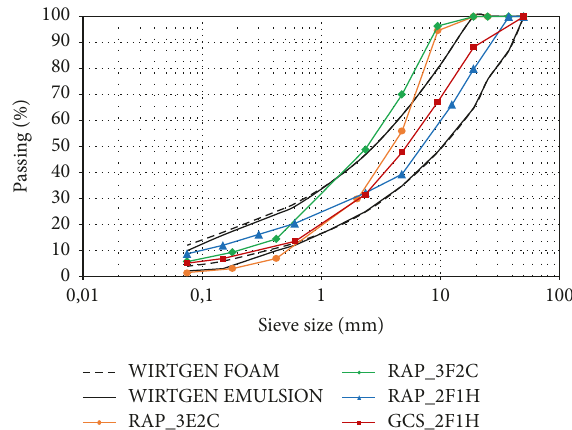
Figure 3: Scheme of recycled